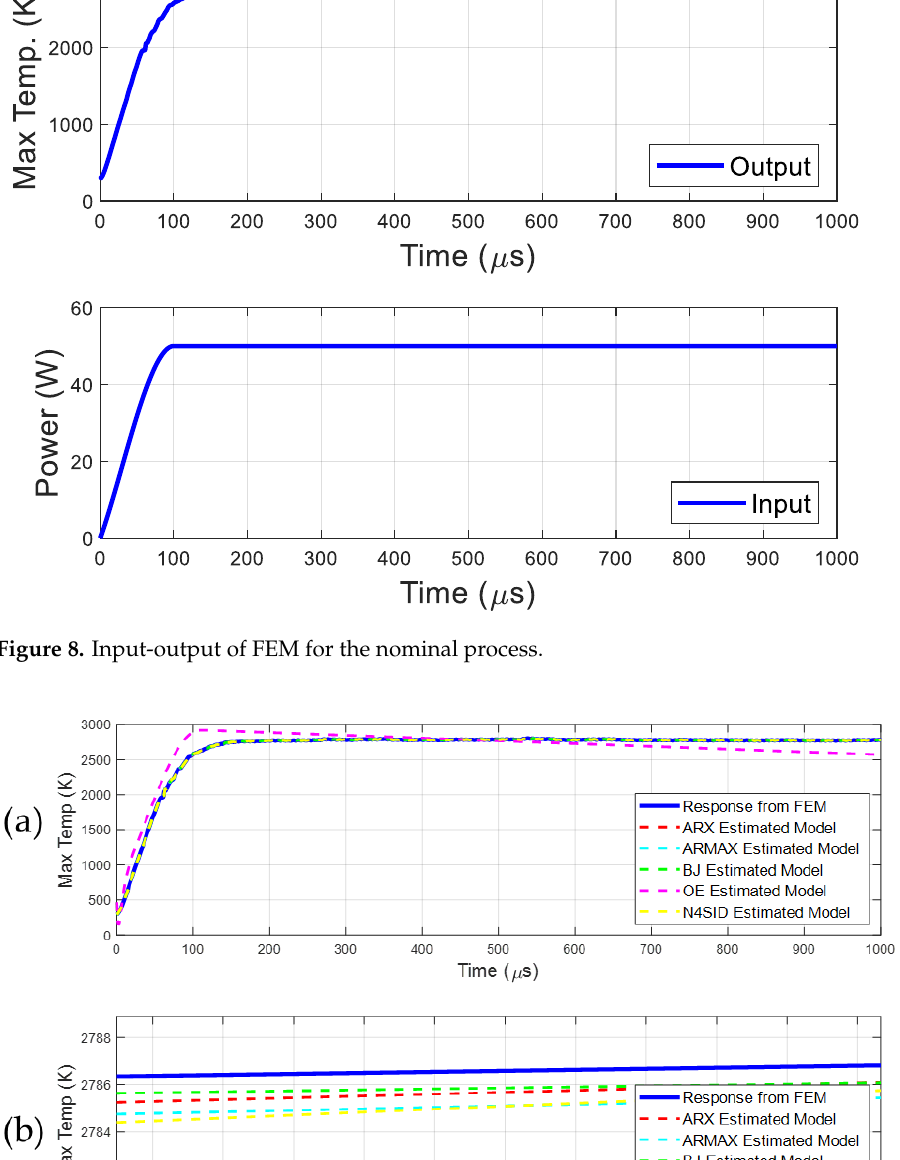
Figure 8. Input-output of FEM for the nominal process.